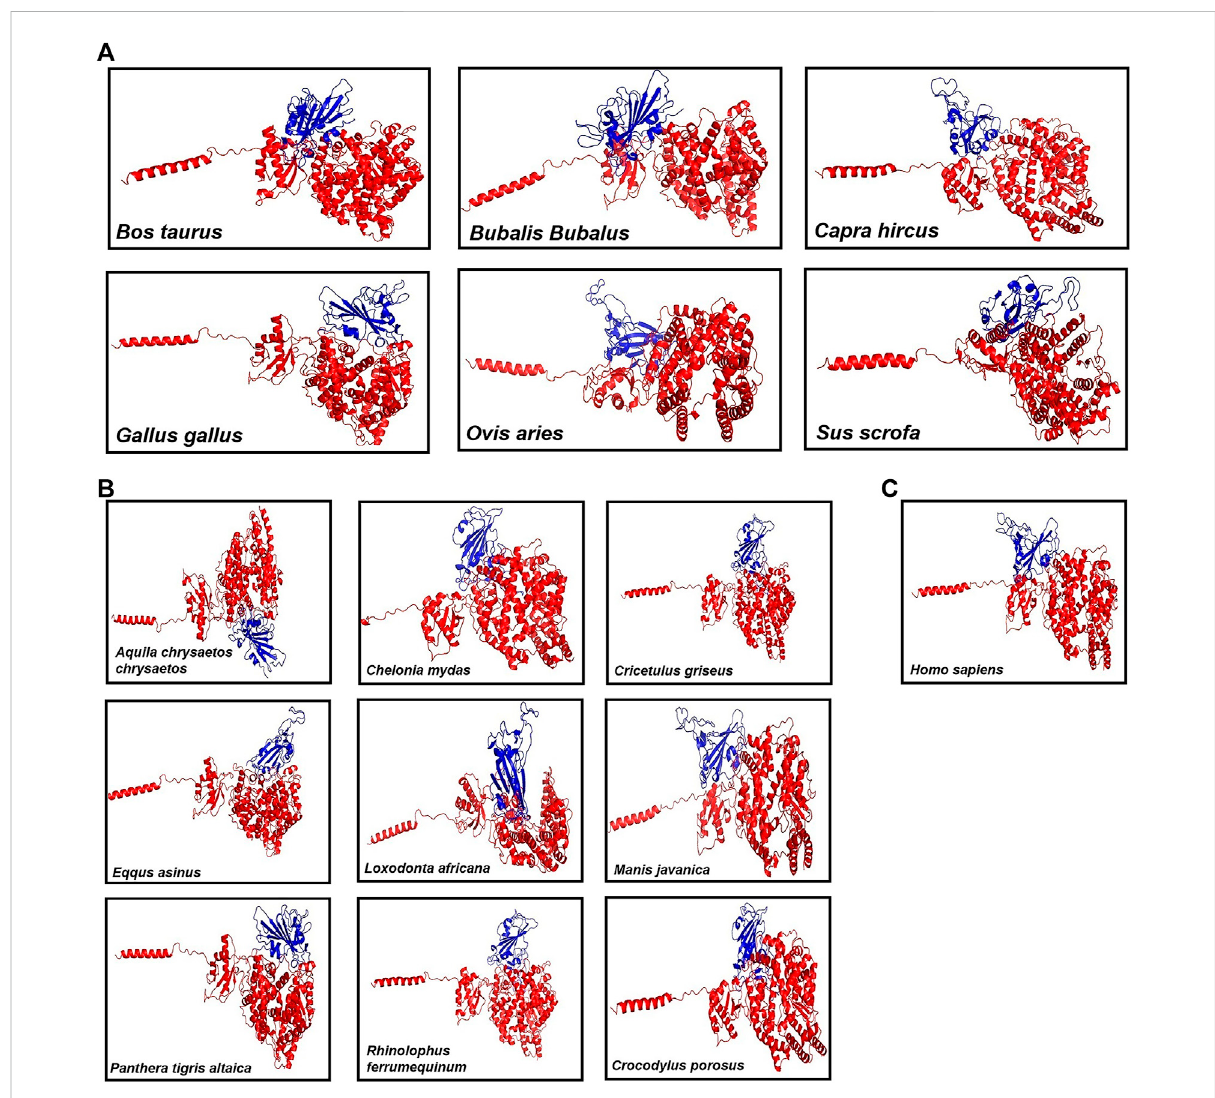
FIGURE 1 Figure showing the 3D models of the ACE2 receptor with spike protein of (A) six Livestock animals, (B) nine wild animals, and (C)